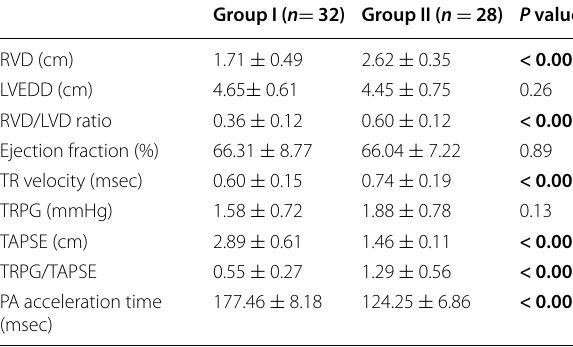
Table 3 Echocardiographic findings in studied